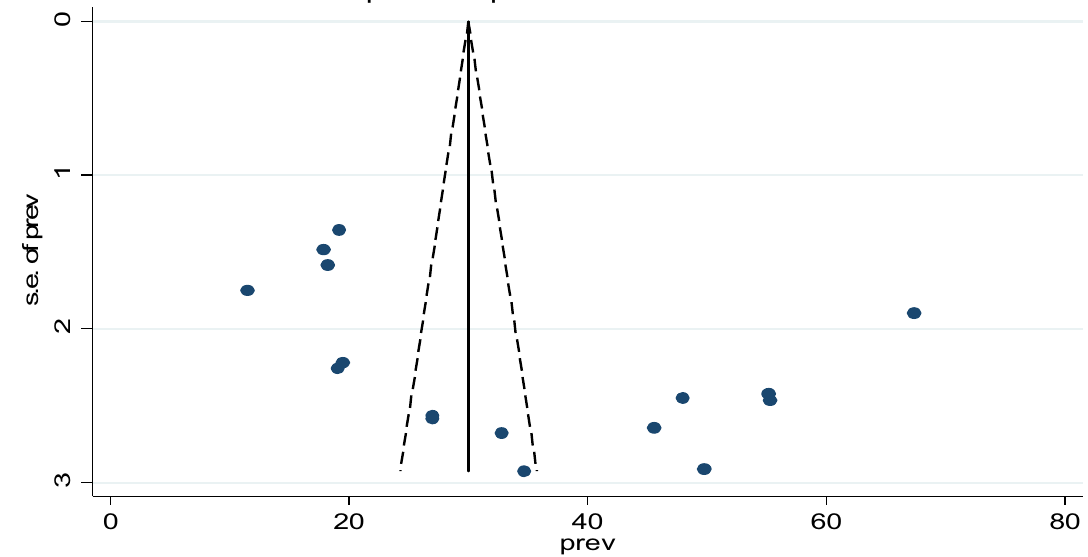
Figure 3. Funnel plot presented the visual inspection of publication bias for systematic review and meta- analysis of food taboo practices among pregnant women in Ethiopia,